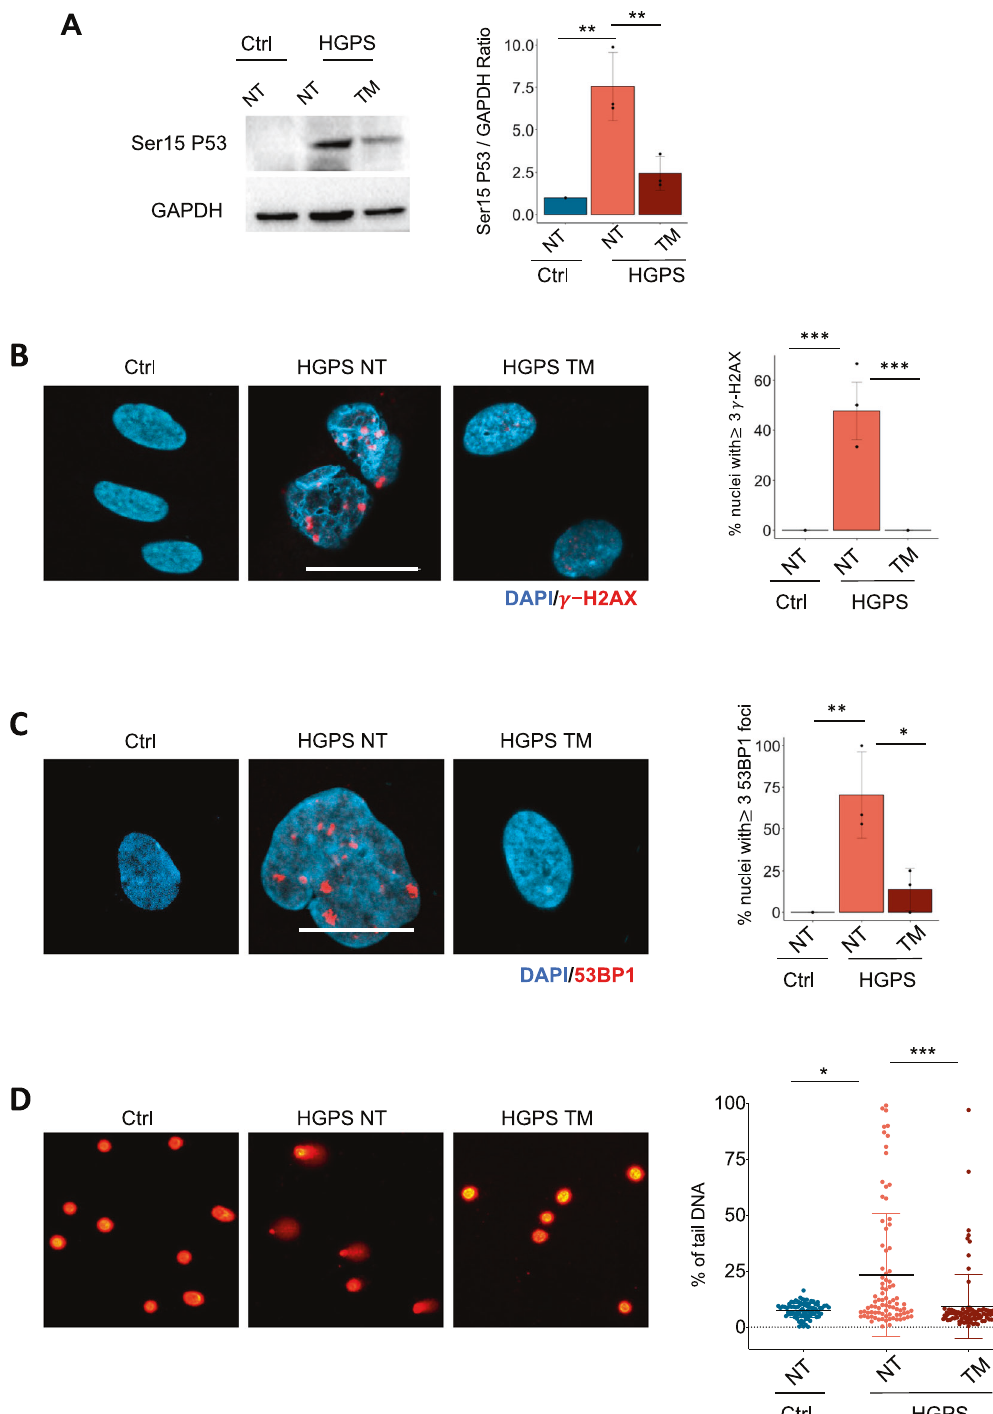
Fig. 3 TM5441 treatment reverts pathological features associated to HGPS. A Cropped immunoblot for p53 phosphorylated at Serine 15 (Ser15 P53) and GAPDH as loading control in 8YO HGPS untreated and treated with TM5441(TM) and age-matched control (Ctrl) cells. Plot represents Ser15 P53/GAPDH ratio based on the average for each experimental point ( n = 3). B Representative images of immuno fl uorescence for γ -H2AX (red) and DAPI (blue) in 8YO HGPS fi broblasts untreated (NT) or treated with TM5441 (TM) and age-matched control (Ctrl). Scale bar 30 μ M. Quanti fi cation of the percentage of nuclei from 8YO HGPS fi broblasts untreated (NT) or treated with TM5441 (TM) and age- matched control (Ctrl) with at least three γ -H2AX foci, ( n = 3). C Representative images of immuno fl uorescence for 53BP1 (red) and DAPI (blue) in 8YO HGPS fi broblasts untreated (NT) or treated with TM5441 (TM) and age-matched control (Ctrl). Scale bar 30 μ M. Quanti fi cation of the percentage of nuclei from 8YO HGPS fi broblasts untreated (NT) or treated with TM5441 (TM) and age-matched control (Ctrl) with at least three 53BP1 foci, ( n = 3). D Representative images of nuclei assayed for Alkaline Comet in 8YO HGPS fi broblasts untreated (NT) or treated with TM5441 (TM) and age-matched control (Ctrl). Quanti fi cation of Alkaline Comet Assay performed in control fi broblasts (Ctrl), 8YO HGPS untreated and treated with TM5441 (TM) for 10 days. The percentage of tail DNA values is represented in the graphs.